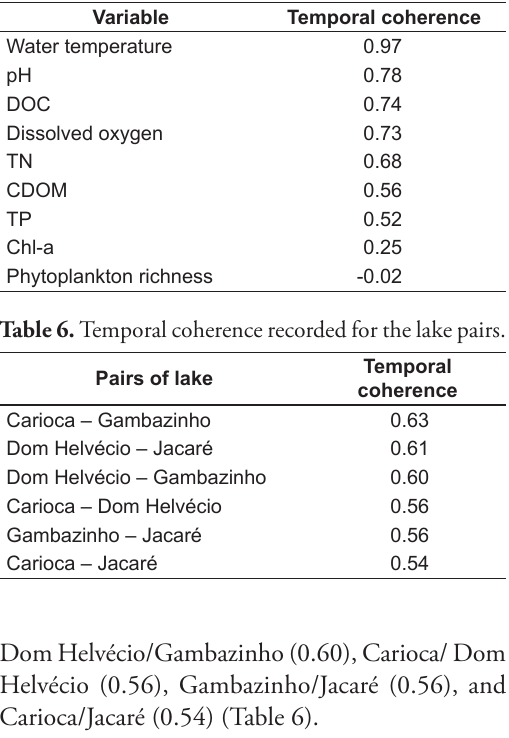
Table 5. Temporal coherence recorded for the different